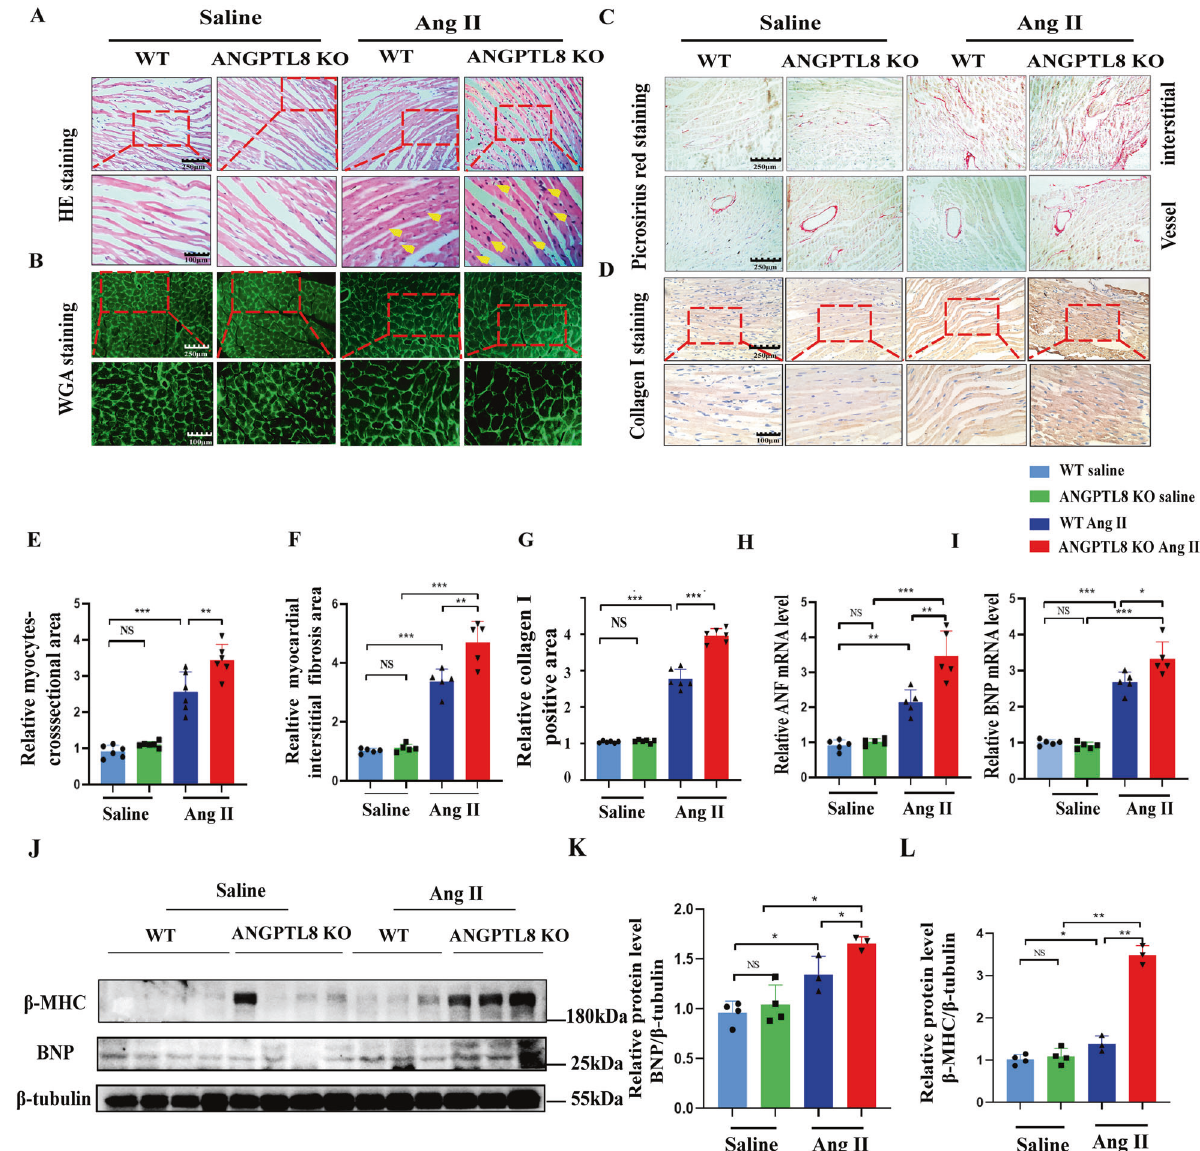
Fig. 3 ANGPTL8KO enhanced hypertrophic and fi brotic marker expression after Ang II infusion for 4 weeks. Representative images of H&E staining ( A ), WGA staining ( B ), picrosirius red (PSR) staining ( C ) and collagen I staining ( D ) of slices from transverse sections of the left ventricles from the mouse hearts in the indicated groups ( n = 5 mice per group, scale bars, 250 μ m and 100 μ m, respectively). Quanti fi cation of the average myocardial interstitial area ( E ) and myocyte cross-sectional areas ( F ) in WT and ANGPTL8-KO mice at 4 weeks ( E n > 40 fi elds and F n = 100 cardiomyocytes from 5~6 mice in each group, NS no signi fi cant difference, ** P < 0.01, *** P < 0.001). G Quantitative results of the collagen I-positive area from collagen I immunochemical staining in WT and ANGPTL8-KO mice ( n = 5 mice in each group, ** P < 0.01). H , I mRNA levels of ANF and BNP were analyzed by qRT – PCR from WT and ANGPTL8-KO mouse hearts ( n = 5 mice in each group). J Representative Western blots of β -MHC and BNP in cardiac tissue from WT and ANGPTL8-KO mice ( n = 3). K , L Quantitative statistical results of β -MHC and BNP protein levels ( n = 3, NS no signi fi cant difference, *P < 0.05, ** P < 0.01, *** P < β -MHC (Fig. 4E, F, I – L) and the fi brotic markers CTGF (connective ANGPTL8 ameliorated cardiomyocyte hypertrophy induced by tissue growth factor) and collagen III (Fig. 4G, H) in Ang II-treated Ang II in vitro cells. In addition, rANGPTL8 also alleviated the hypertrophic To evaluate the speci fi c role of ANGPTL8 in cardiomyocyte morphology and beating frequency of NRCMs stimulated with hypertrophy in vitro. First, recombinant human full-length Ang II (Supplementary Fig. S5A, B). Consistently, ANGPTL8 ANGPTL8 protein (rANGPTL8, 500 ng/ml) was used to treat overexpression alleviated cardiac hypertrophy induced by Ang II, cardiomyocytes (NRCM and H9c2) stimulated with or without leading to a damper response to Ang II-induced hypertrophy Ang II (1 µM) for 48 h. rANGPTL8 had no apparent effects on the based on the analysis of cell surface area and the expression level cellular surface of cardiomyocytes (NRCM and H9c2) without of β -MHC (Fig. 4M, P). adding Ang II but strongly decreased cardiomyocyte enlargement ANGPTL8 was secreted from the liver, so we treated primary induced by Ang II (Fig. 4A – D). Meanwhile, rANGPTL8 reduced the hepatocytes with Ang II for 12 h and then collected the culture mRNA levels of both the hypertrophic markers ANF, BNP, and